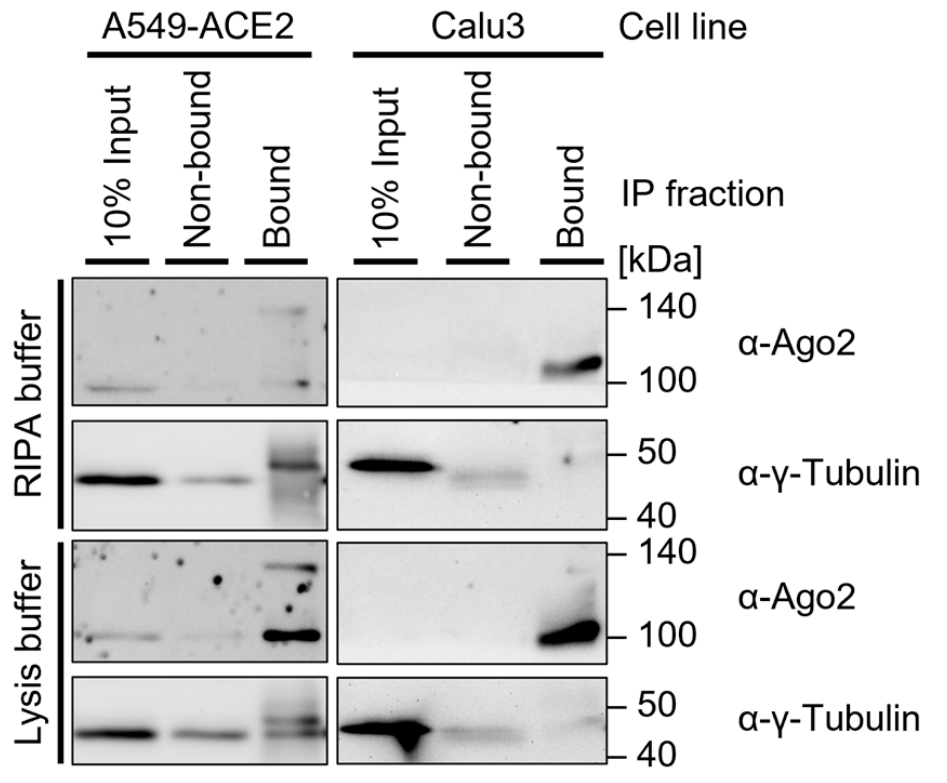
Figure 4. Western blot of immunoprecipitation in two cell lines: A549-ACE2 and Calu3. Both cell lines were UV-crosslinked (300 mJ/cm 2 ), lysed in 4× RIPA buffer or lysis buffer, and sonicated (2 × 15 s, duty cycle/pulse 40%, output control/amplitude 5), then incubated with 0.5 µg α -Ago2 Clone